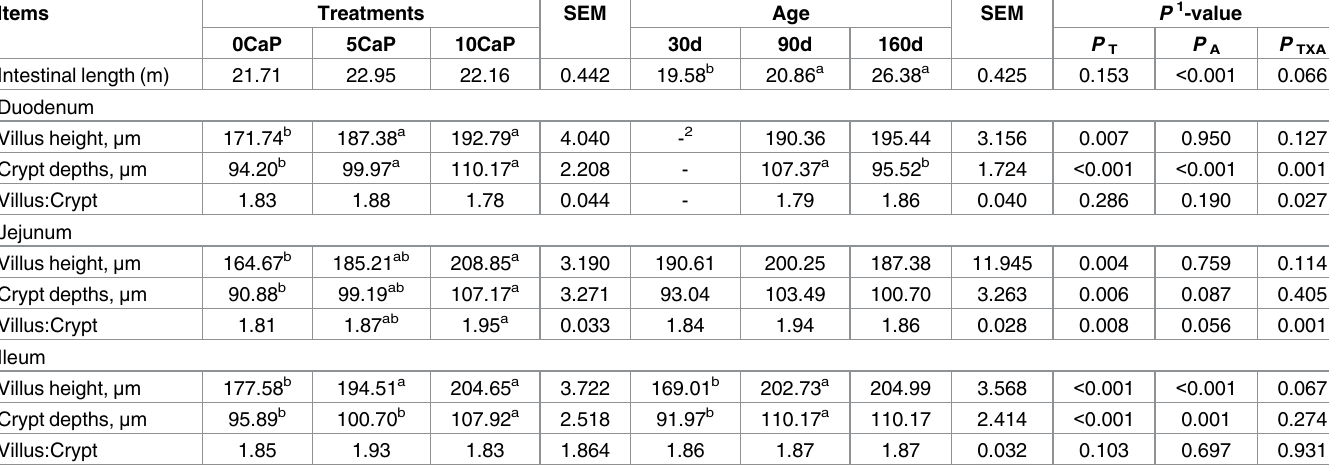
Table 5. Effects of CaP supplementation and ages on intestinal development and morphological measurements of